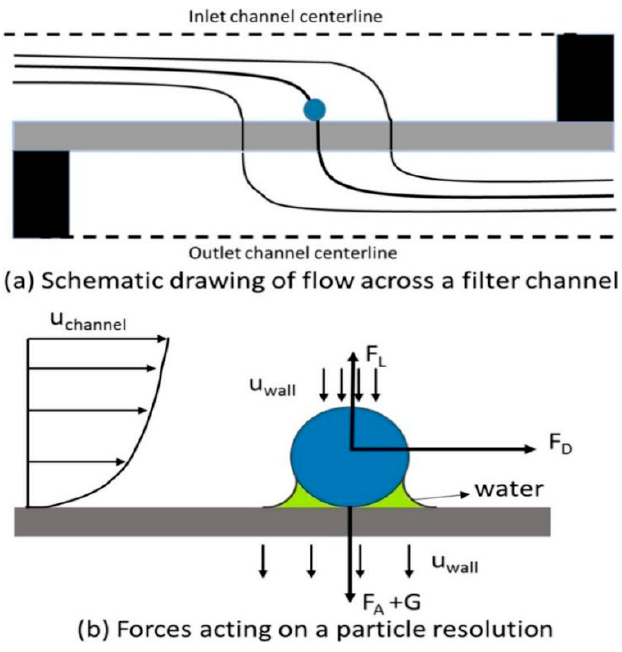
Figure 13. Force on particles